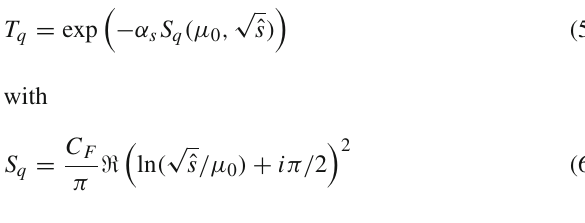
logarithm accuracy and corrections to it will appear only at NNLO. As shown in Ref. [3], the NNLO is rather small after the choice of the optimal scale and that justifies our